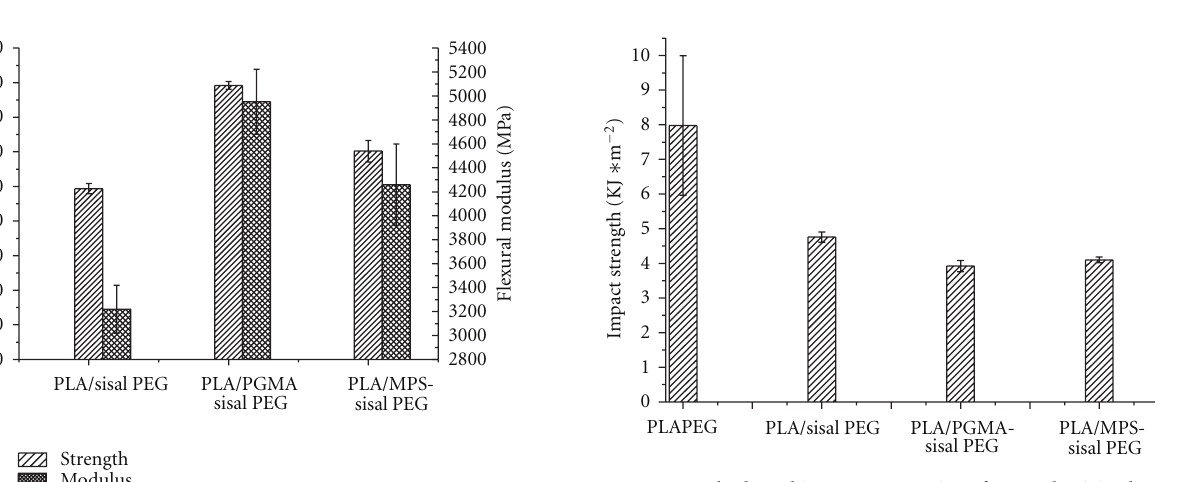
Figure 6: Notched Izod impact properties of PEG Plasticized PLA and their